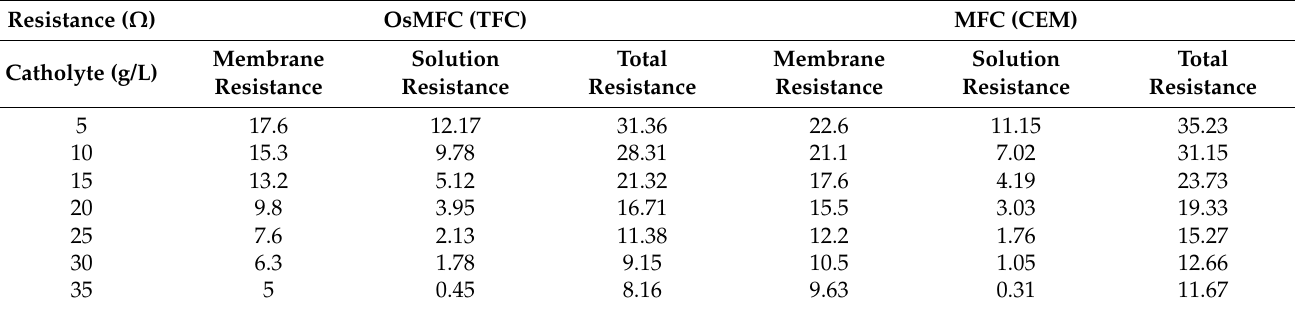
Table 1. Comparative analysis of internal resistance composition between the OsMFC and MFC.